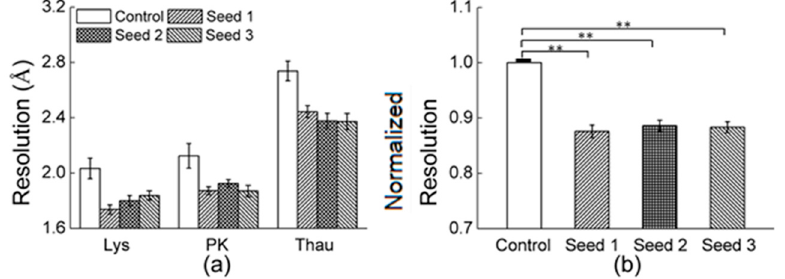
Figure 2. One-way ANOVA analysis on the resolution limit, the error bars showing the standard error of the mean. ( a ) A comparison of the resolution limits of the protein crystals obtained in the presence and absence of CLPC seed; ( b ). The averaged normalized resolution limits in the presence and absence of CLPC seed. (** represents saliency). In terms of the resolution limit of protein crystals, the results showed that there were significant differences between the control group and other groups. (n = 3, p < 0.05). Crystals with seeds showed better resolution limits.